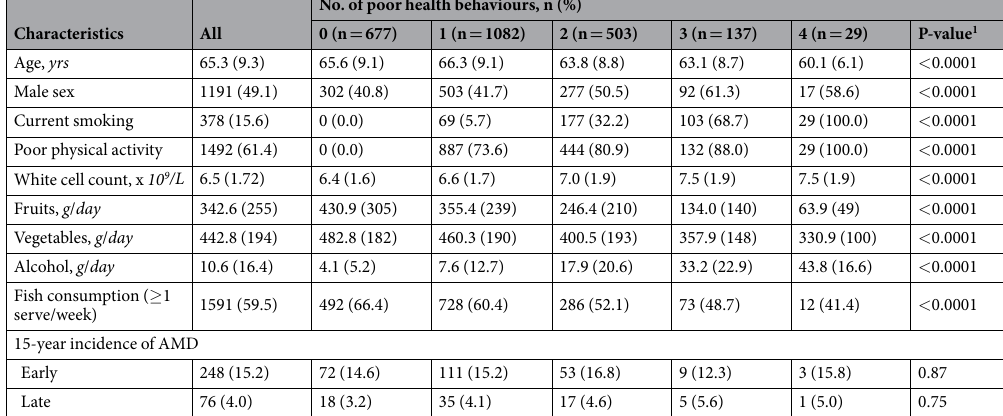
Table 1. Baseline characteristics of study participants stratified by number of poor health behaviours in the Blue Mountains Eye Study (n = 2428). Data are presented as means ± SD or n (%). * Unadjusted p values from test of heterogeneity across categories of health behaviours.